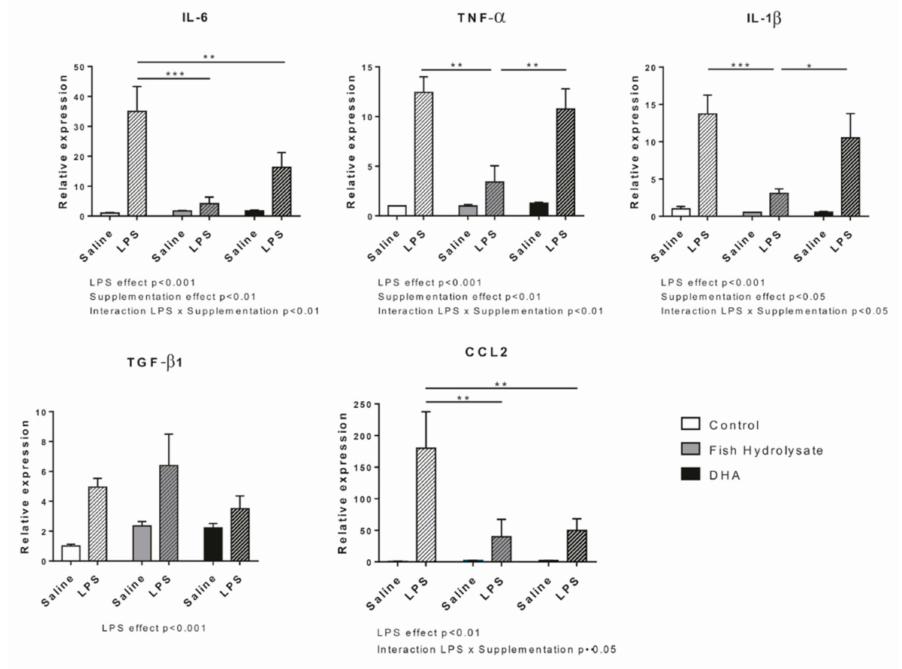
Figure 2. Expression of pro- and anti-inflammatory cytokines (IL-6, TNF- α , IL-1 β , TGF- β 1) and chemokine (CCL2) in the hippocampus of mice fed orally with control solution (in white), fish hy- drolysate (in grey) or DHA (in black) by daily gavage for 18 days, 2 h following LPS injection (125 µ g/kg) (hatched bars) (* p < 0.05, ** p < 0.01, *** p < 0.001 by 2-way ANOVA and Fisher’s LSD post-hoc test; n = 4–6 per group). Data are presented as mean ± SEM. DHA: docosahexaenoic acid; LPS: lipopolysaccharide.